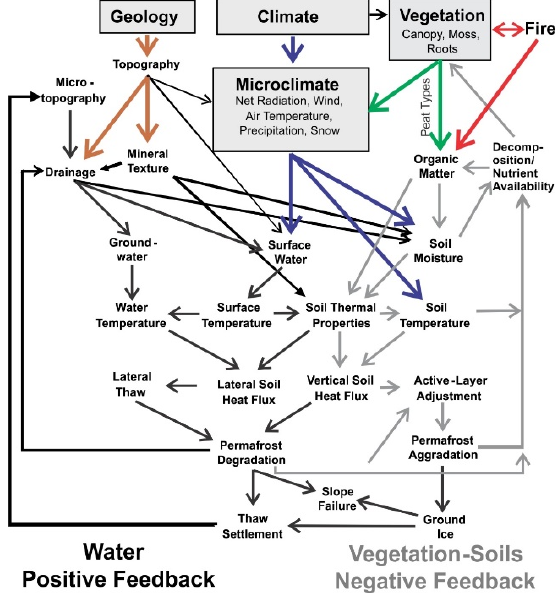
Figure 16. Biophysical interactions and feedbacks affecting permafrost aggradation and degradation (modified from [59]). The main drivers (upper-level factors) evaluated in this study include climate/climate extremes ( blue highlight ), geology/geomorphology/topography ( brown ), fire ( red ), and vegetation/ecological shifts ( green ) that result in both permafrost degradation and aggradation. Data were collected on all biophysical factors except decomposition, thermal properties, heat fluxes, and slope failure (not applicable).